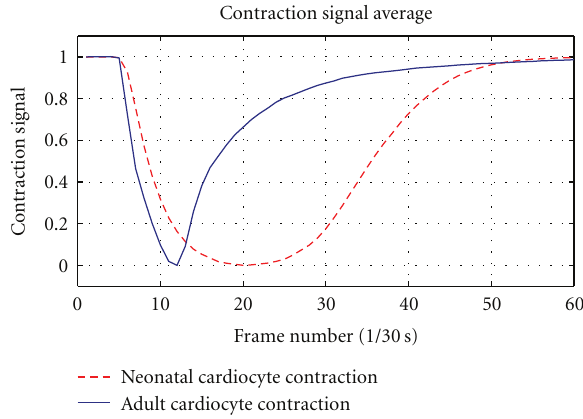
Figure 9: Solid line: average adult cardiocyte relaxation phase mea- sured using image processing-based techniques recently proposed in [17]. Dashed line: average neonatal cardiocyte relaxation phase measured using the proposed methodology. Results are in accor- dance with the expected outcomes given the marked di ff erences in the development of both cell types and their di ff erence in Ca 2+ handling.